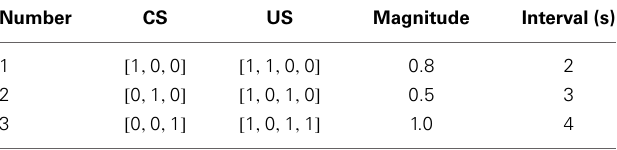
Table 1 | Definition of the inputs to the